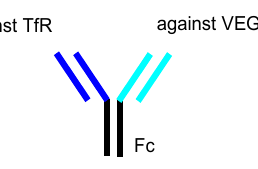
Figure 8. One of the structures of bispecific IgG against transferrin receptor (TfR) and vascular endothelial growth factor (VEGF).